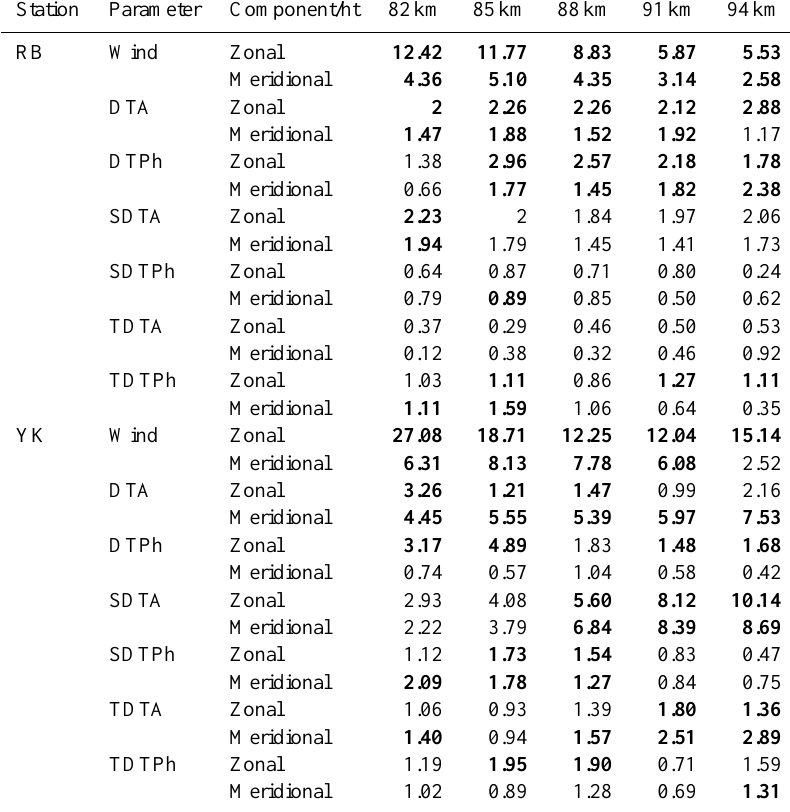
Table 2. Amplitudes of Annual oscillation of mean Wind; Diurnal Tide amplitude (DTA), phase (DTPh); Semidiurnal Tide amplitude (SDTA), phase (SDTPh); and Terdiurnal Tide amplitude (TDTA), phase (TDTPh) for both zonal and meridional components over Resolute Bay (RB) and Yellowknife (YK). Note that the highlighted values have more than an 80% significance